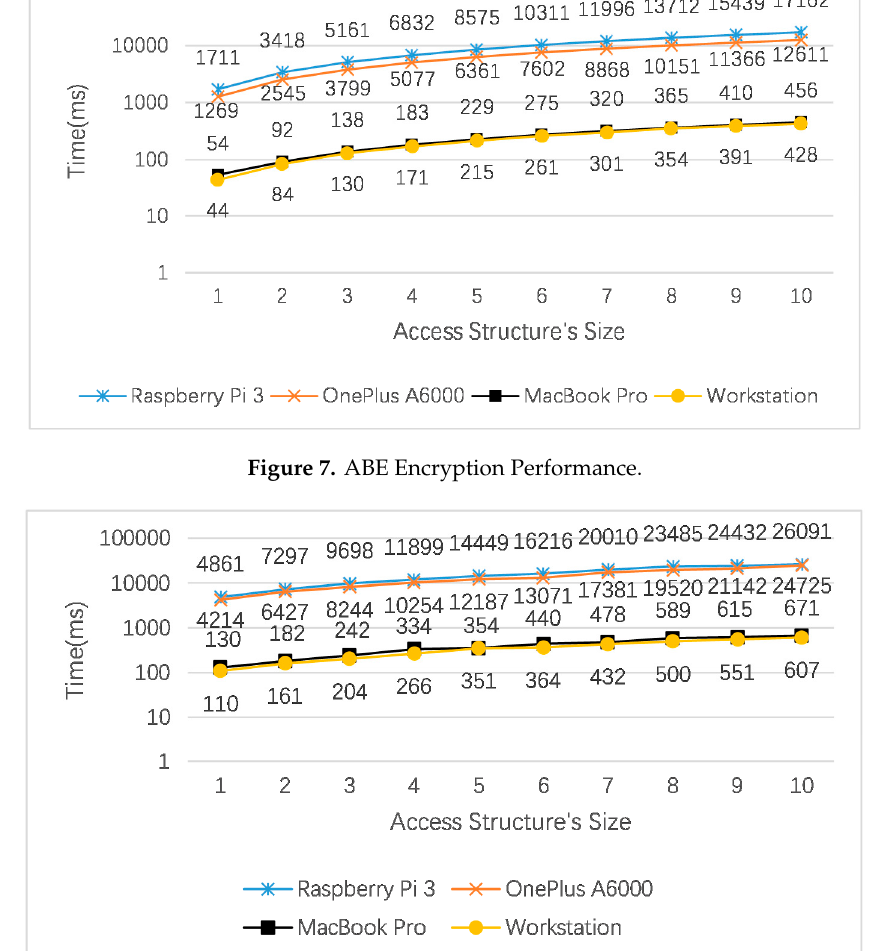
Figure 8. ABE Decryption Performance.